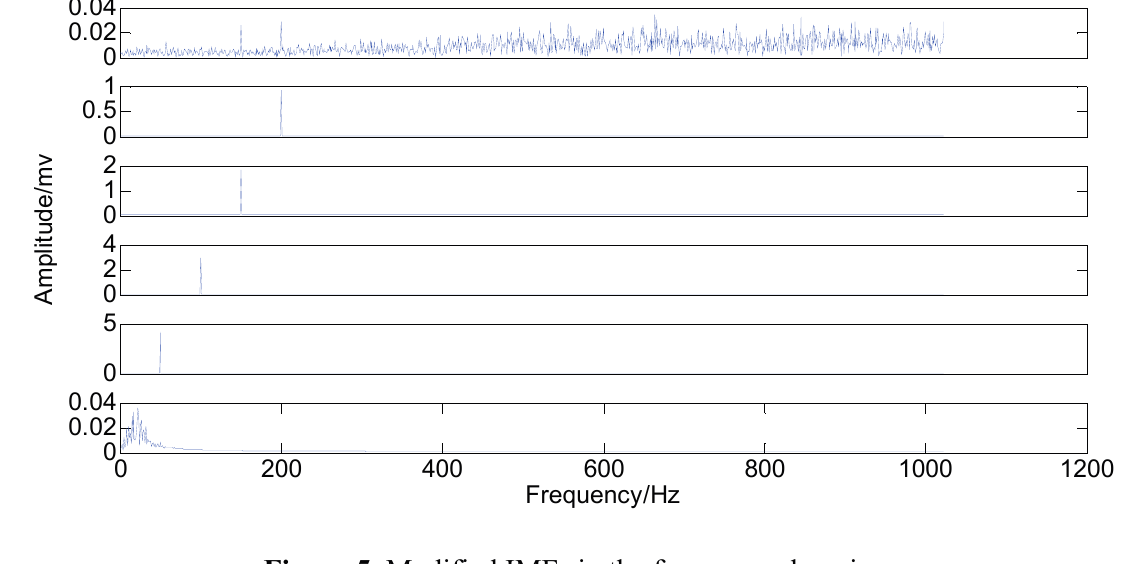
Figure 5. Modified IMFs in the frequency-domain.